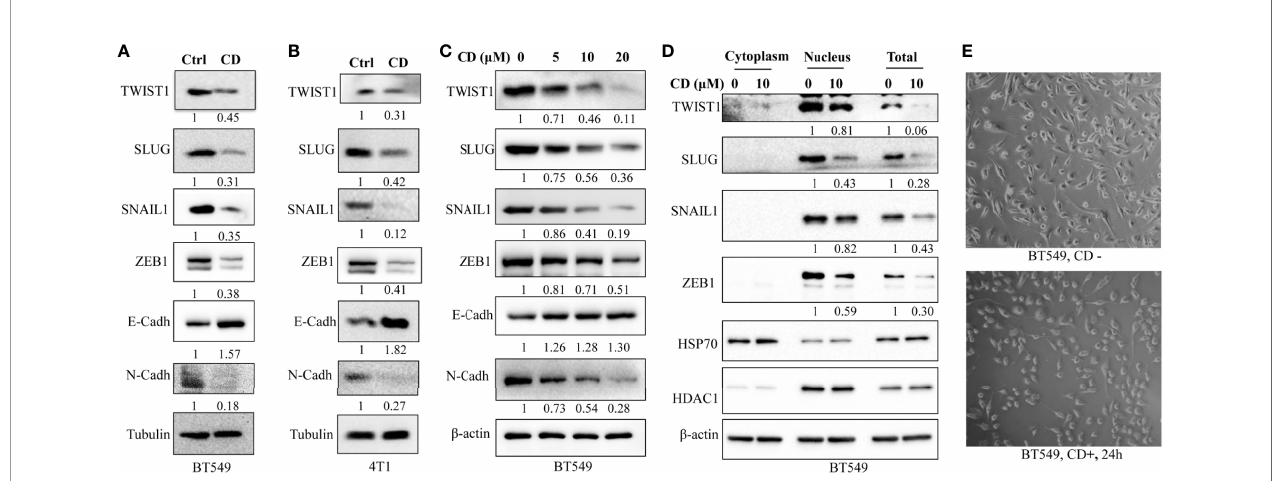
FIGURE 3 | Effects of cordycepin on the expression of EMT-associated proteins. (A) EMT-TF expression in BT549. (B) EMT-TF expression in 4T1. For protein level expression analysis, cancer cells were treated with 10 µM of CD for 24 h, cellular protein was lysated, and Western blot analysis was performed. Results are repeated twice. (C) EMT-TF expression in BT549 treated with the indicated concentration of CD. For protein level expression analysis, cancer cells were treated with 0, 5, 10, and 20 µM of CD for 24 h, cellular protein was lysated, and Western blot analysis was performed. Results are repeated twice. (D) CD reduces EMT-TF nuclear localizations. BT549 treated without or with the indicated concentration of CD, proteins from cytoplasm, nucleus, or total were extracted using Nuclear and Cytoplasmic Protein Extraction Kit, and Western blotting was conducted by indicated antibodies. HADC1 was served as a nucleus marker and HSP70 was served as a cytoplasm marker. (E) Cell morphology in the BT549 cell line. N-Cadh, N-Cadherin; E-Cadh, E-Cadherin. Tubulin or b -actin was set as an internal control.